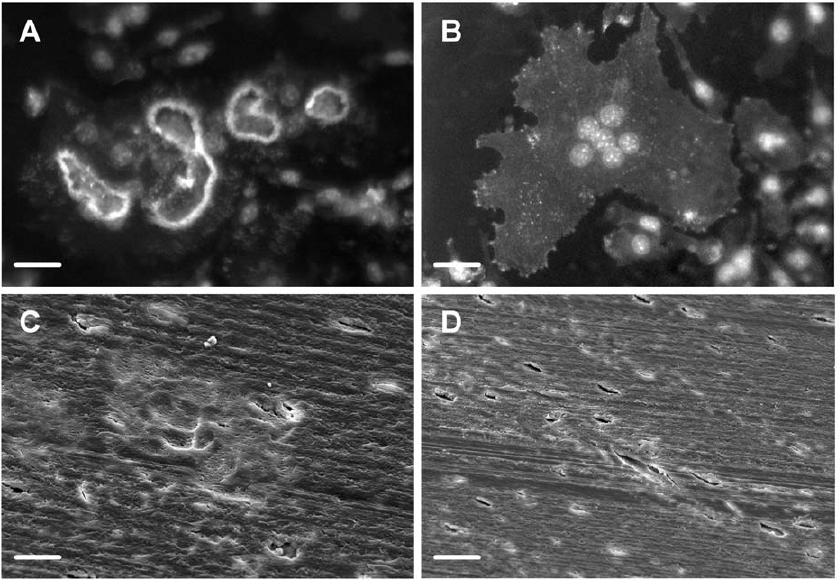
Figure 8. Vitronectin coating of anorganic bone enables podosome belt formation and resorption. Osteoclasts were incubated for 5 hours in MEM/BSA with M-CSF (50 ng/ml), RANKL (30 ng/ml) and IL-1 a (10 ng/ml) on slices of anorganic bone coated with vitronectin or fibronectin (50 m g/ml). Podosome belts and excavations were frequently seen on vitronectin-coated anorganic bone slices (A, C), but were never seen on fibronectin-coated anorganic bone slices (B, D). A, B: Phalloidin/DAPI staining; C, D: SEM images. Scale bars A–C: 25 m m; D: 50 m m.